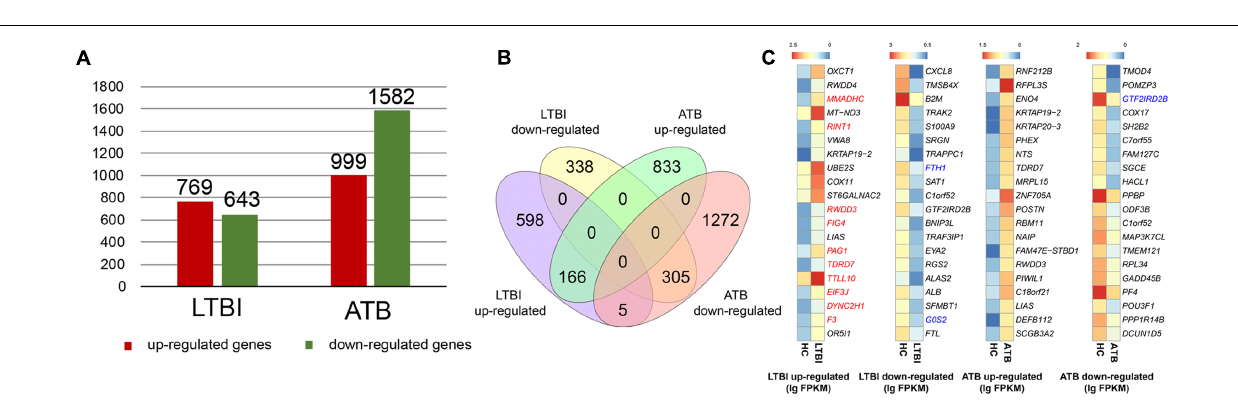
FIGURE 3 | Expression panels of serum exosomes for the LTBI and ATB samples. (A) The bar plot showed the numbers of DEGs in the LTBI and ATB compared with HC. Red bars indicated the number of up-regulated genes in each sample, while the green bars indicated the number of down-regulated genes in each sample. (B) Venn diagram of DEGs showing the relatively distinct expression panels between the ATB and LTBI samples. (C) Heatmaps of top-20 DEGs in LTBI and ATB: colors indicate the estimate of base 10 log ratio of expression levels that ranges from blue (low expression) to red (high expression). The three genes (labeled with blue color) showed the same down-regulated expression trends in both peripheral blood mononuclear cell (PBMC) and serum exosomes. The 10 up-regulated genes in LTBI (labeled with red color) were enriched in GO functions of protein binding or protein